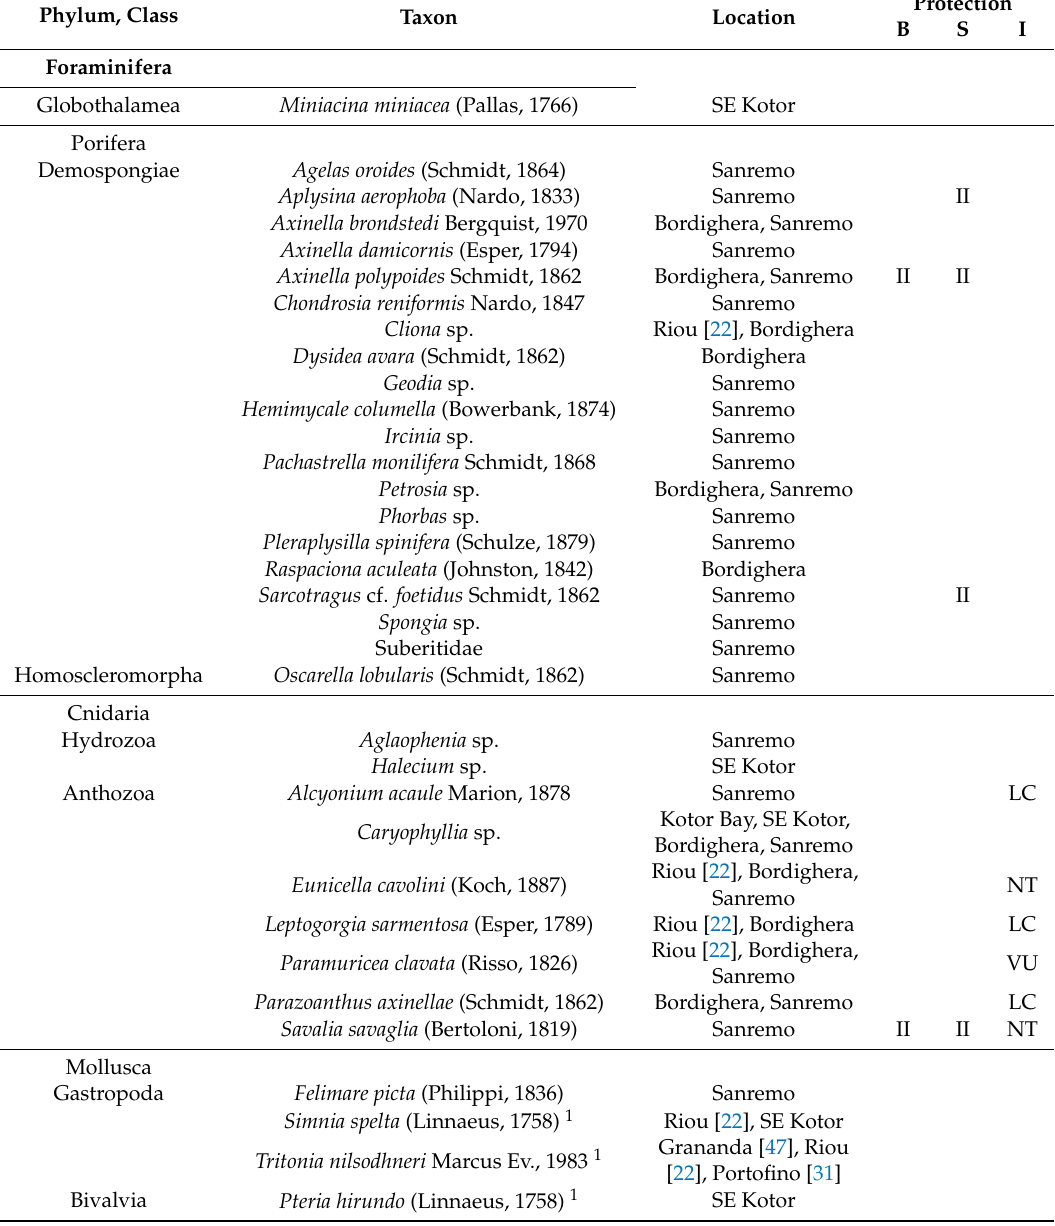
Table 2. List of the animal taxa observed in association with Eunicella verrucosa and its forests, with indication of the location and the protection framework. B: Bern Convention (Convention on the Conservation of European Wildlife and Natural Habitats: Appendix II and III), S: SPA / BD Protocol (Protocol for Specially Protected Areas and Biological Diversity in the Mediterranean, Barcelona Convention: Annex II and III), I: International Union for Conservation of Nature (IUCN), Red List (LC: least concern, NT: near threatened, VU: